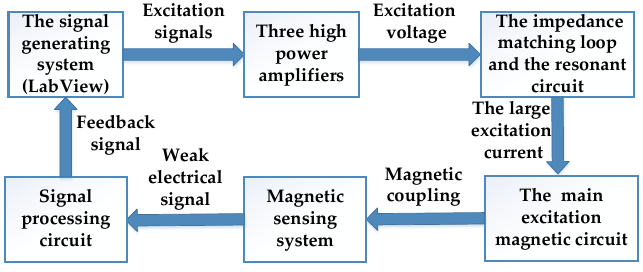
Figure 2. Structure block diagram of the measuring system of vector magnetic property.